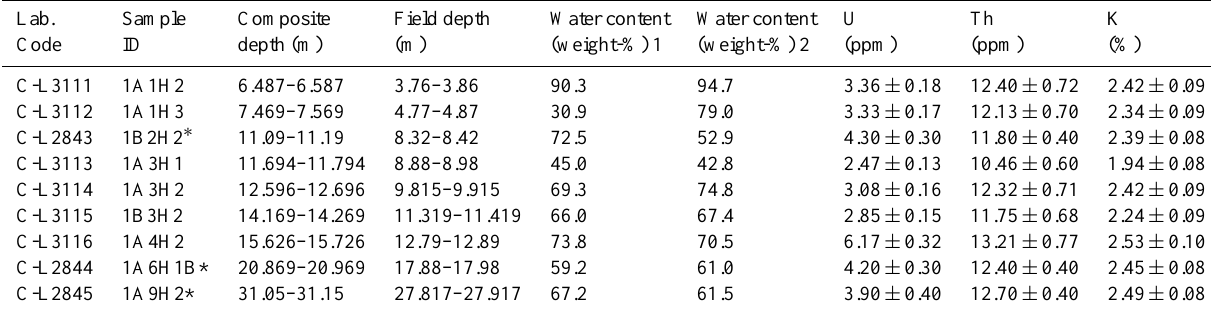
Table 1. Results of dose-rate determination using high-resolution gamma-ray spectrometry. Samples marked with an asterisk were measured at the VKTA Rossendorf e.V. The other 5 samples were measured at the luminescence laboratory in Cologne. Water content 1 was measured by drying the bulk sediment finally used for dose rate measurements and water content 2 was measured at a second correlative core soon after drilling. Water content 2 was later used for age calculations. All water content values are quoted as weight water/weight dry sediment. All values are presented with their 1-sigma